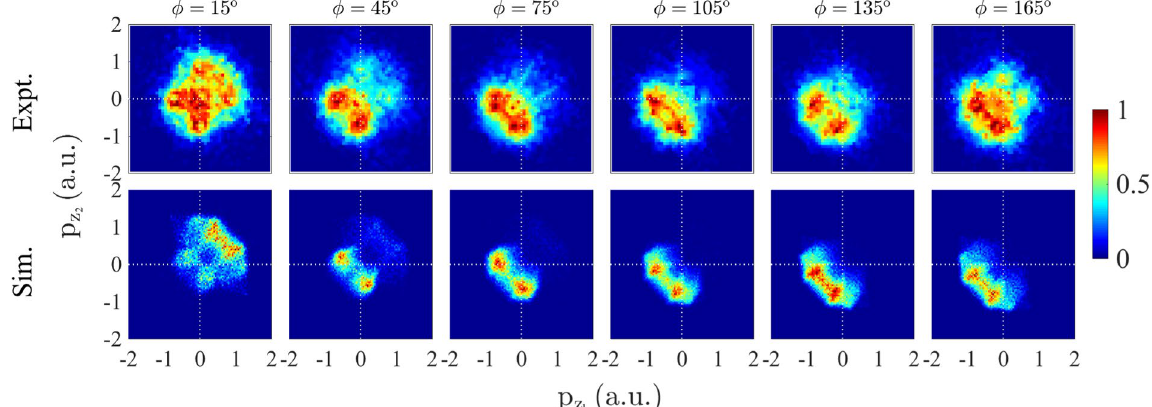
Figure 10. Correlated electron momenta at an intensity of 0.85 × 10 14 W/cm 2 for φ ranging from 15° to 165° with a step of 30°. For φ ranging from 15° to 165° the experimental results from ref. 28 are compared with the computed results. Each double differential distribution is divided by its maximum value.